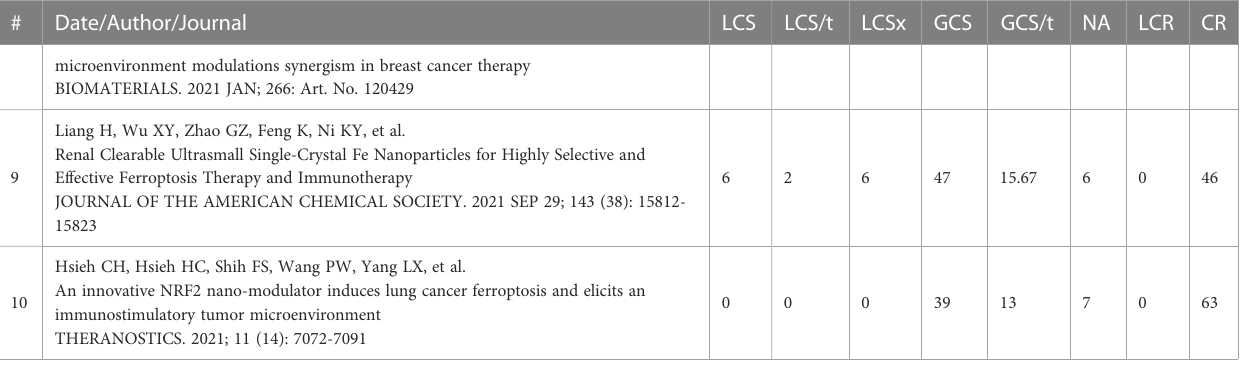
Table 5. Most of the nanoparticles mentioned above were constructed based on the synergistic effect of ferroptosis and immunotherapy.